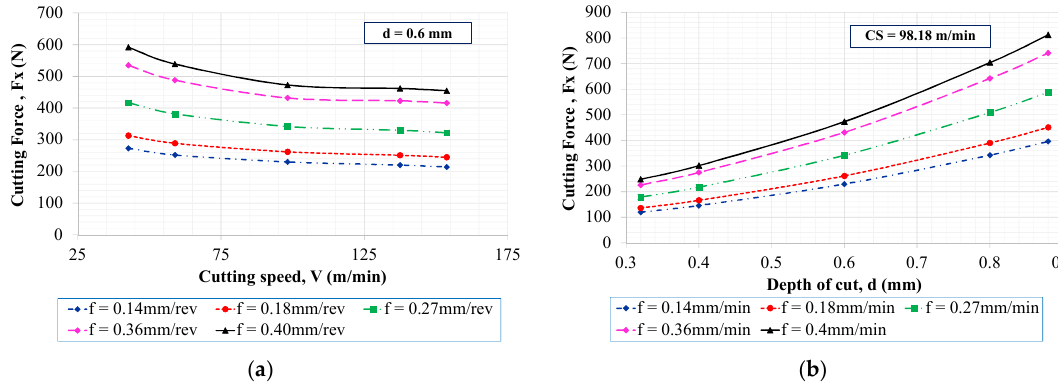
Figure 6. The effect of ( a ) cutting speed ( b ) depth of cut on cutting forces (x-direction) for different feed.